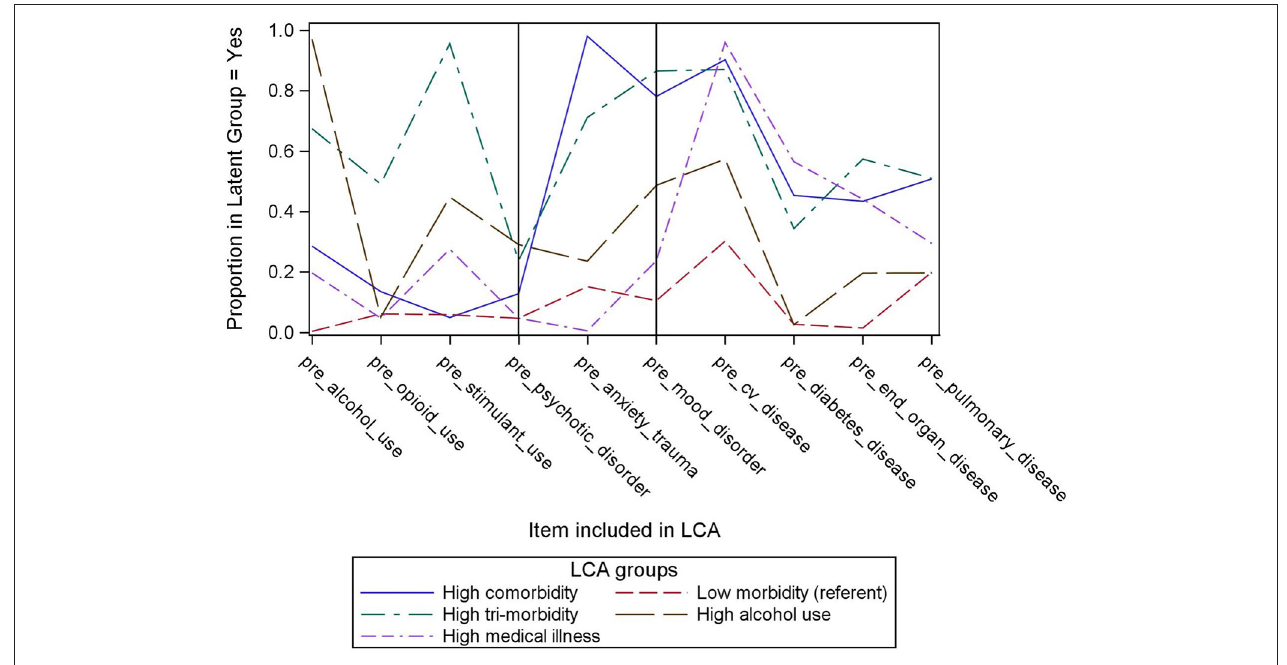
FIGURE 1 | Five latent classes of adults referred to a homeless transitional care program.